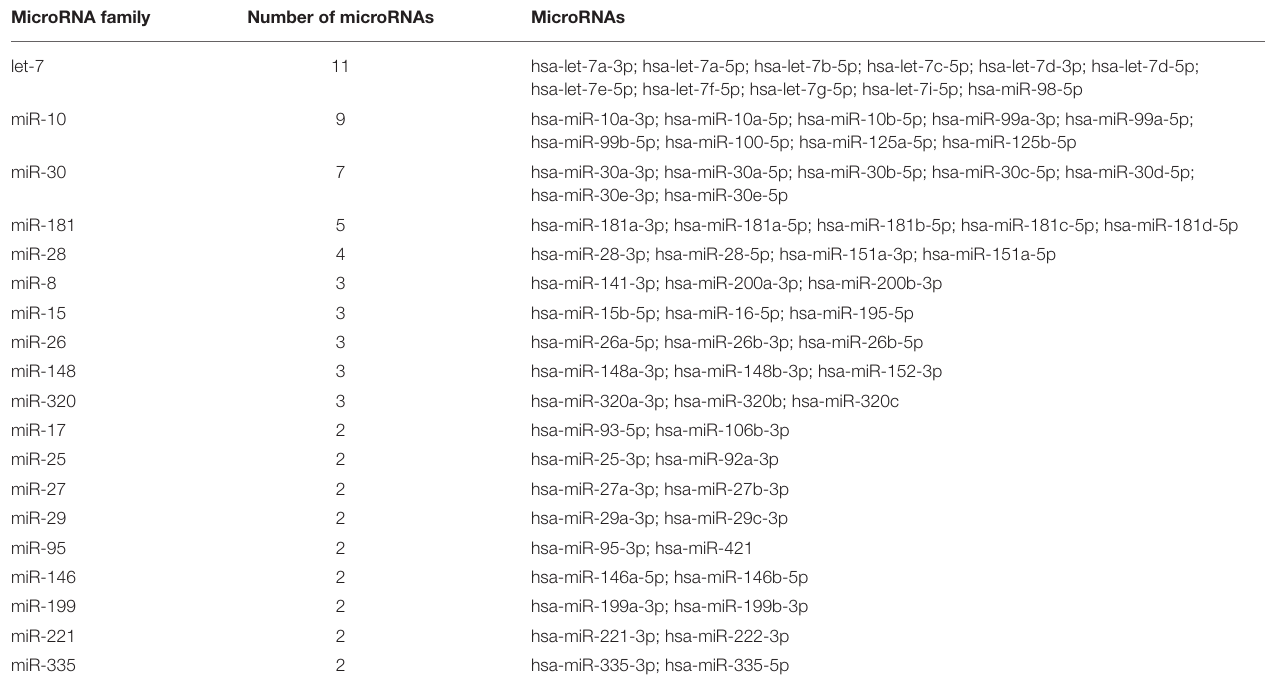
TABLE 3 | MicroRNA families with two or more microRNAs detected in all pericardial fluid samples. MicroRNA family Number of